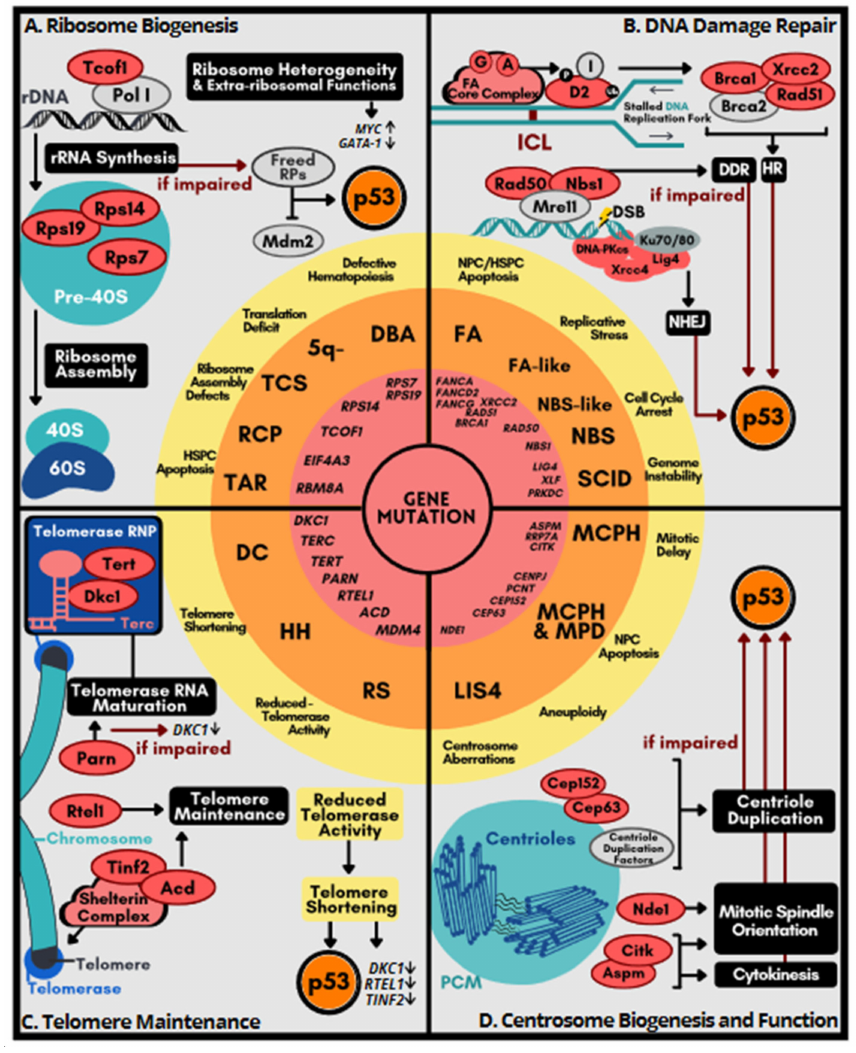
Figure 2. Cellular processes implicated in p53 hyperactivation-associated genetic disorders. Genetic alterations (mutation/deletion; red circle in the center) lead to their respective human congenital disorders (orange zone) via disruption of various cellular processes or activities, including ribosome biogenesis ( A ), DNA damage repair ( B ), telomere maintenance ( C ), and centrosome duplication ( D ) as depicted in the four quadrants. p53 hyperactivation as a common feature shared across these genetic aberrations in murine models is depicted in the most center of this figure. The resulting molecular and cellular defects (yellow zone) underlie each group of disorders. Red ovals indicate the encoded proteins that, when dysregulated or absent, contribute to the syndrome discussed in the text. Hyperactive p53 is represented by a bold red-filled circle, as opposed to p53 at baseline in white-filled circle. Abbreviations: RCP, Richieri-Costa–Pereira; RS, Revesz syndrome; LIS4,